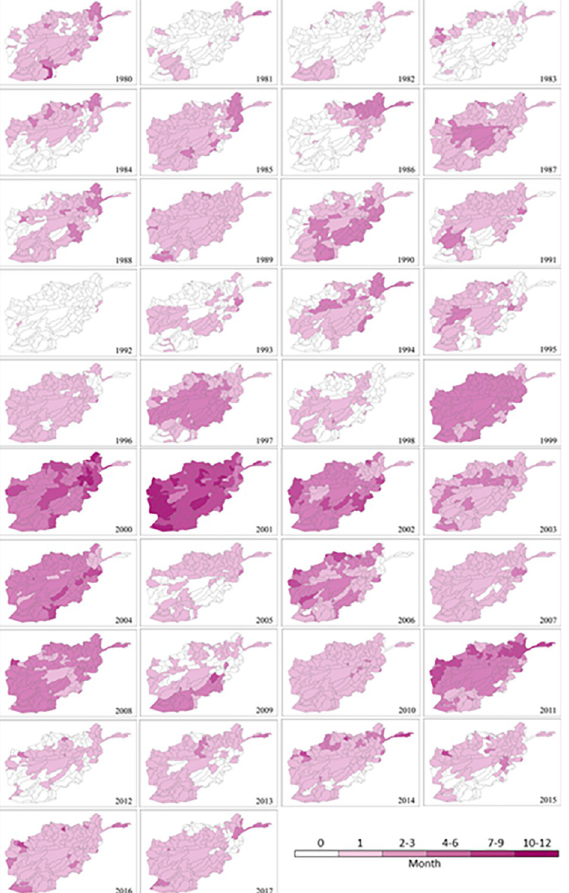
Fig 7. Spatial distribution of mean annual maximum drought duration at sub-catchment scale in Afghanistan for each year between 1980 and 2017 based on SPEI-1 (monthly scale).